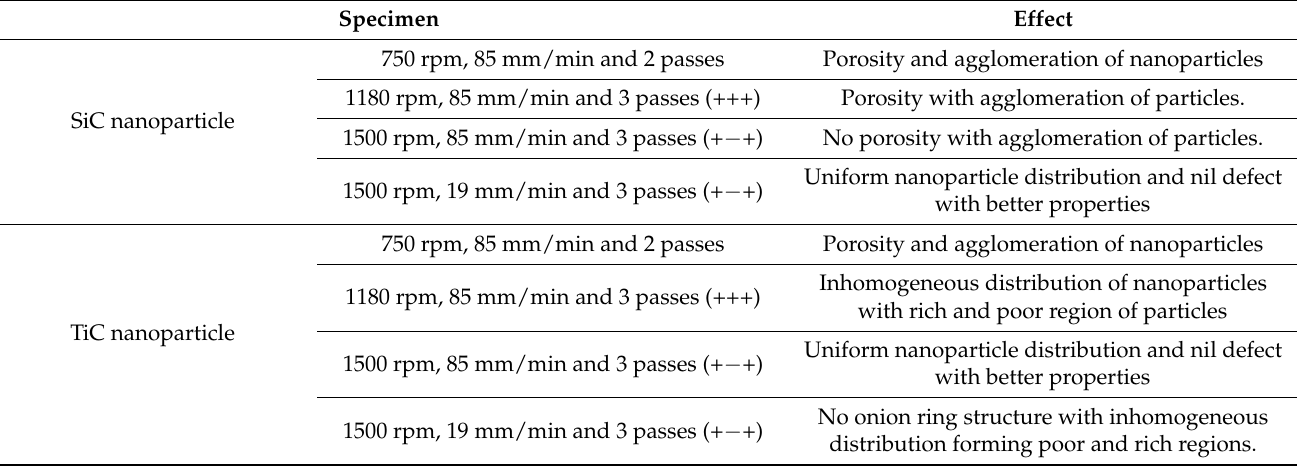
Table 1. FSW parameters variation influence on nanoparticles distribution and its AA6082 joint characteristic.